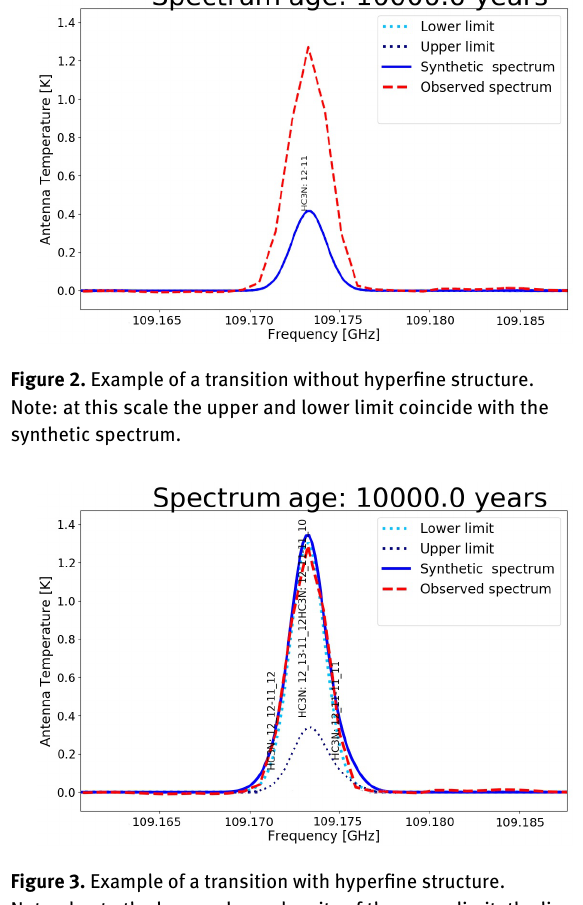
GHz. Figure 2 shows this line when the hyperfine structure is not present. Modelling the same transition taking into account the hyperfine structure, results in Figure 3. Even though the individual transitions are not resolved, it is clear that the blended line fits the observed spectrum much bet-